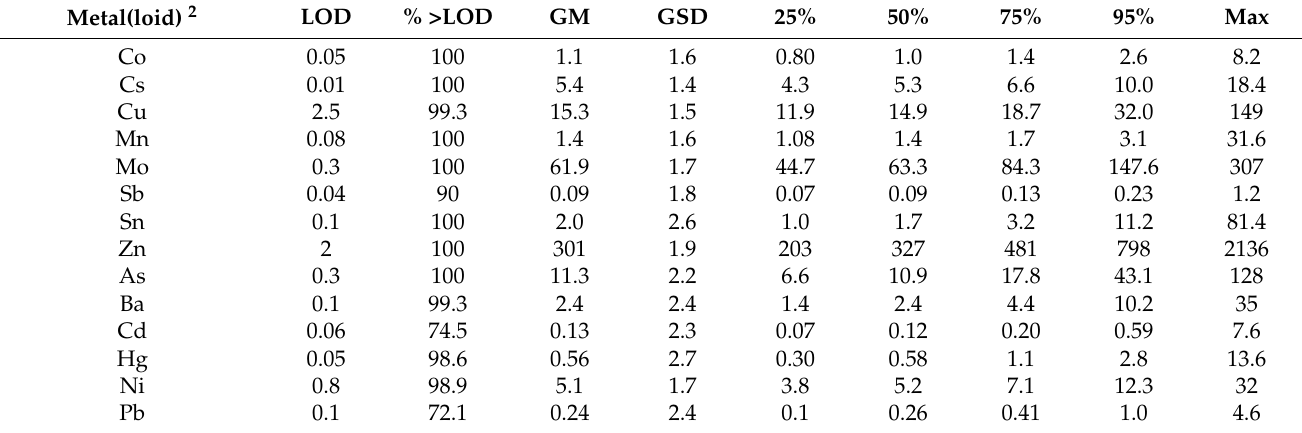
Table 2. Urinary concentrations of metal(loid)s (ng/mL) and oxidative stress biomarkers (ng/mL) in 215 pregnant women from Puerto Rico 1